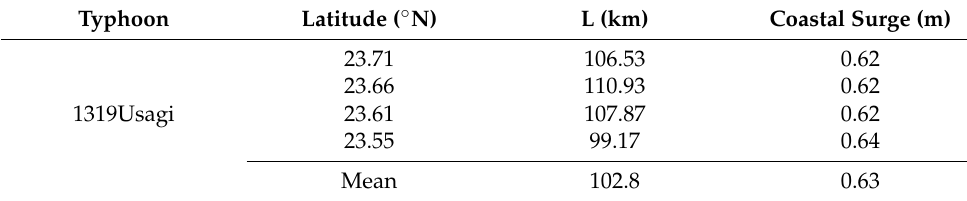
Table 1. Cross-shelf decaying scale and coastal surge by fitting Jason-2 data for Typhoon 1319Usagi. Typhoon Latitude ( ◦ N) L (km) Coastal Surge (m)